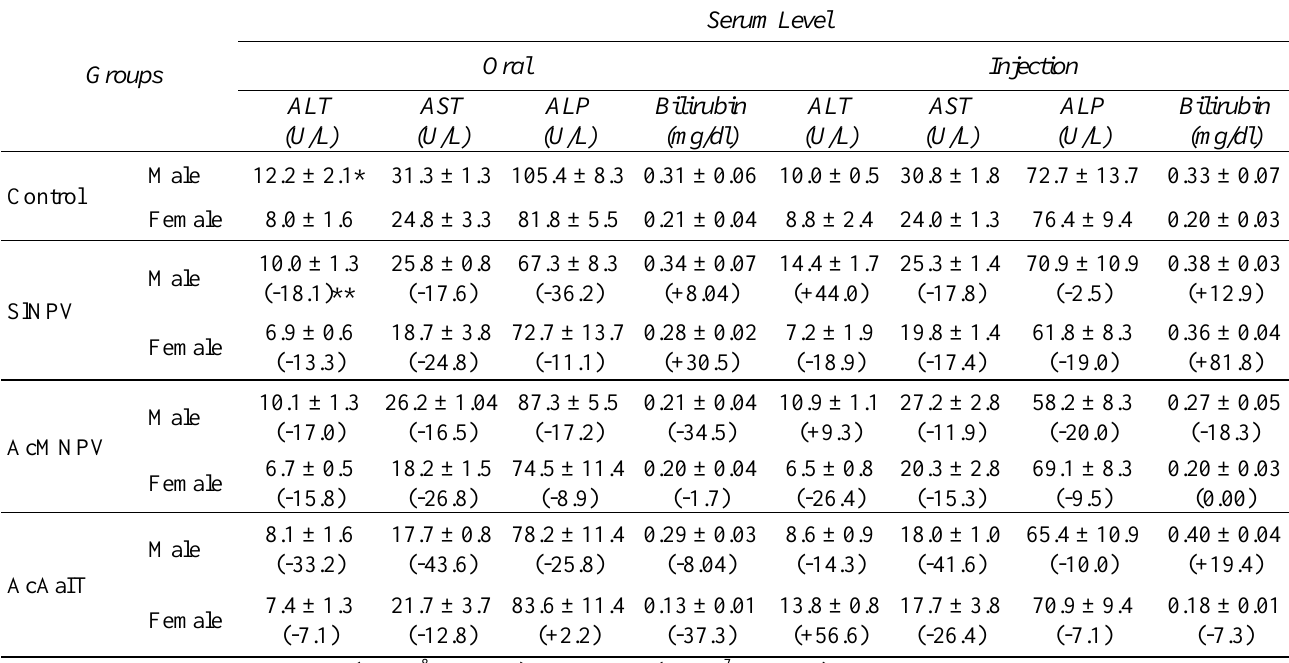
Table 8: Levels of alanine aminotransferase (ALT), aspartate aminotransferase (AST), alkaline phosphatase (ALP), and bilirubin in rat serum at 21 days after oral or intraperitoneal administration of SlNPV, AcMNPV or